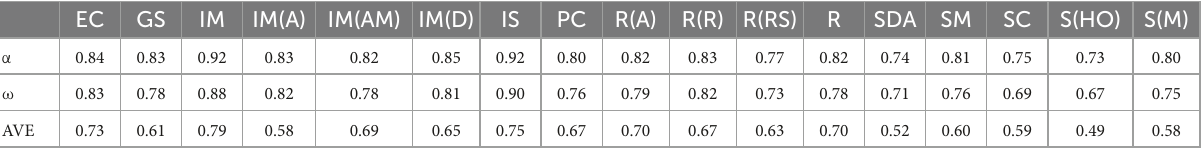
TABLE 4 Average variance extracted and reliability analysis of OxFAB-MAW.